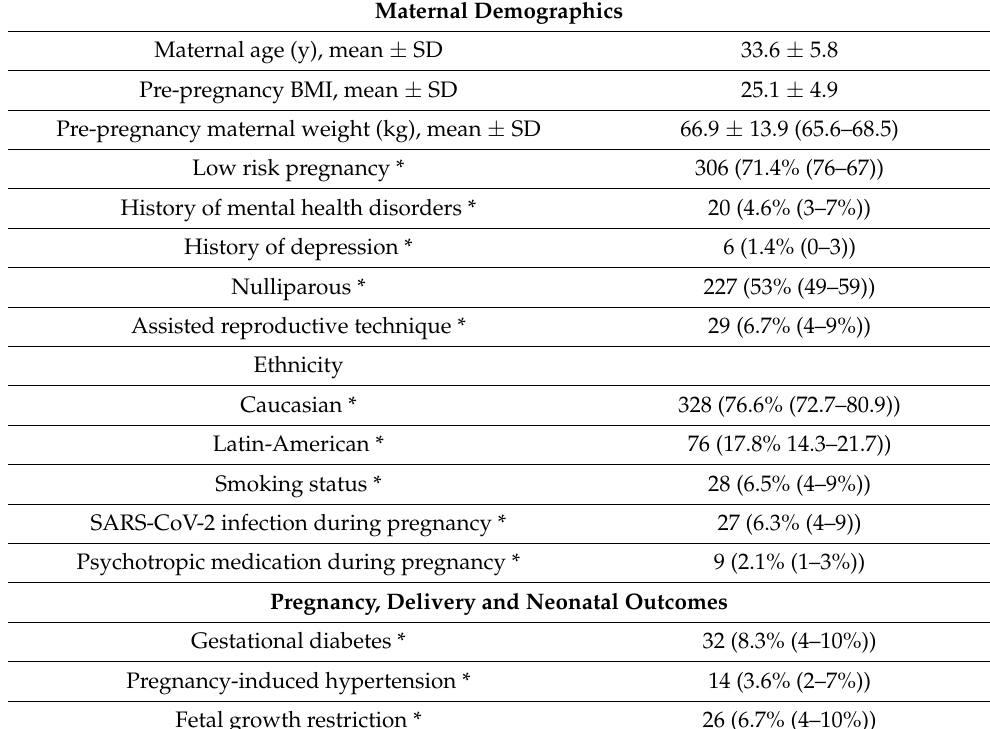
Table 1. Maternal demographics, and pregnancy, delivery and neonatal outcomes ( n = 428).